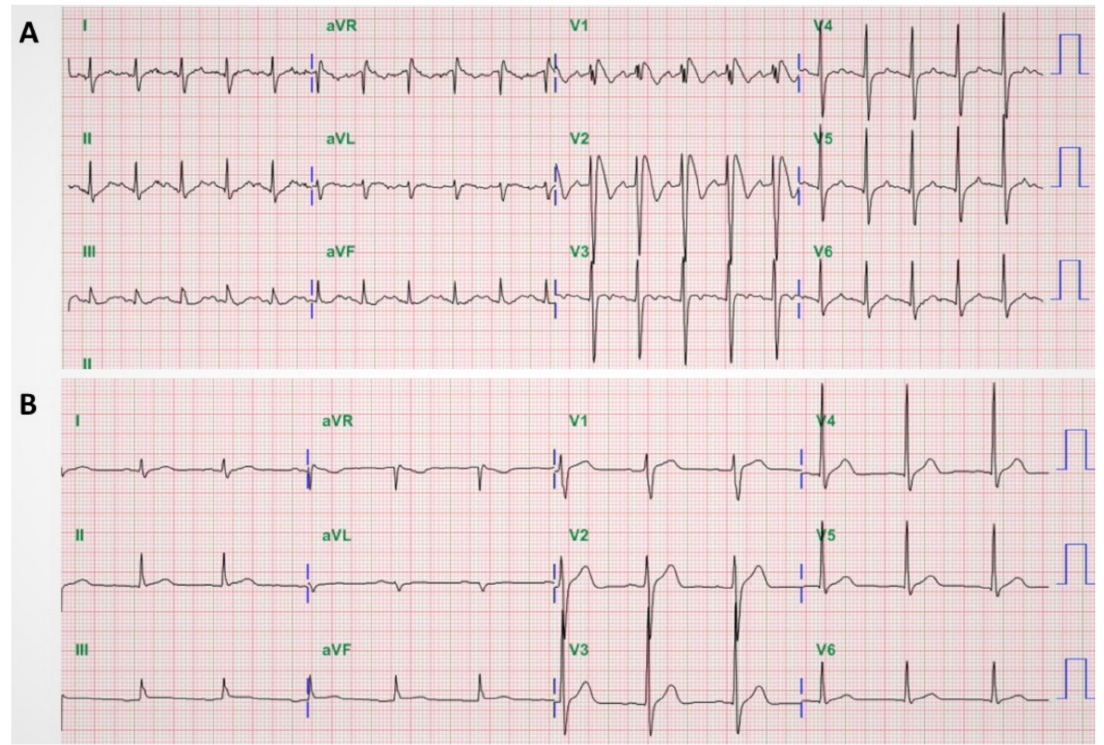
Figure 1. Fever-induced Brugada electrocardiography (ECG) pattern. A 45-year-old man was admitted with diarrhea and abdominal cramps for 2 days. He was febrile (temperature, 40 ◦ C) with tachycardia (pulse, 127 beats/min): ( A ) ECG on admission revealed a right bundle-branch block with coved ST-segment elevation in V 1 –V 2 followed by a negative T wave; ( B ) repeated ECG after fever resolved showed normalization of the ST-segment elevation, as well as disappearance of the right bundle-branch